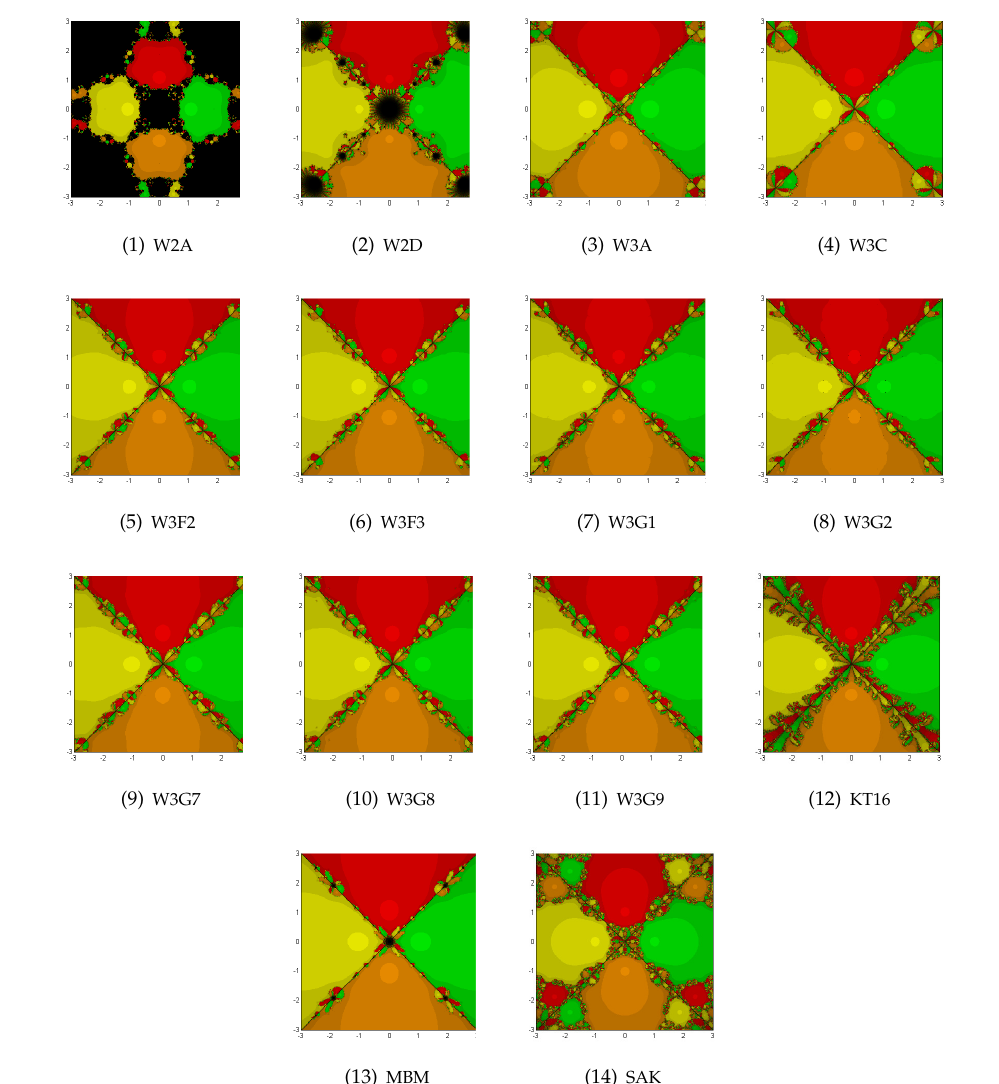
Figure 4. The top row for W2A (left), W2D (center left), W3A (center right), and W3C (right). The second row for W3F2 (left), W3F3 (center left), W3G1 (center right), and W3G2 (right). The third row for W3G7 (left), W3G8 (center left), W3G9 (center right), and KT16 (right). The bottom row for MBM (left), SAK (center left), for the roots of the polynomial equation ( z 4 − 1 )